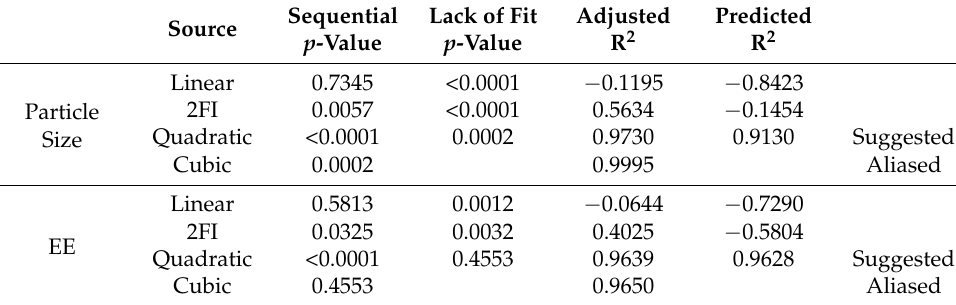
Table 2. Model summary statistics of selected